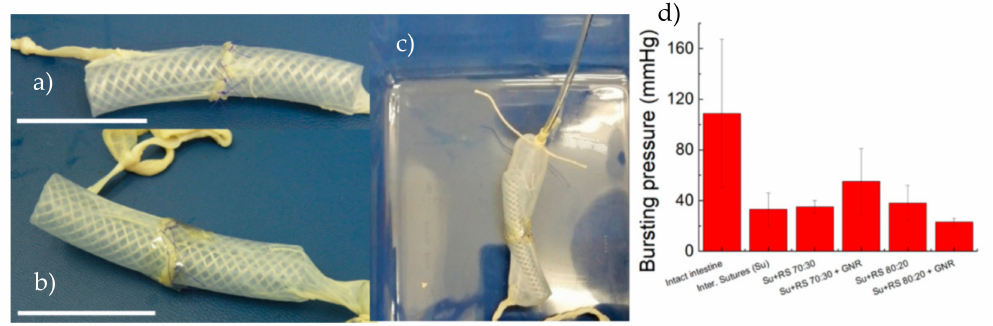
Figure 4. Photographs of ( a ) sutured porcine intestine to determine the anastomosis bursting pressure and ( b ) RS film placed over the suture. The scale bars indicate 5 cm. ( c ) Photograph showing the intestine while is inflating with water and its dilatation until rupture. ( d ) Bursting pressures values obtained from rupture of intact intestine, interrupted sutured (Su) intestine, RS and RS-GNR films on sutured intestine,